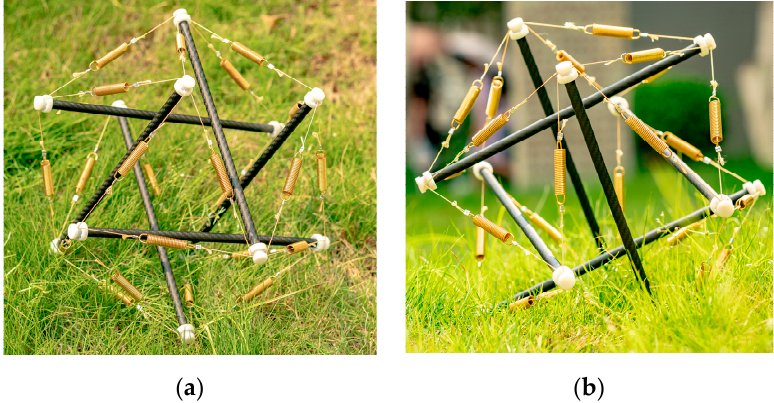
Figure 4. A model of the six-bar tensegrity structure: ( a ) top view, ( b ) front view.